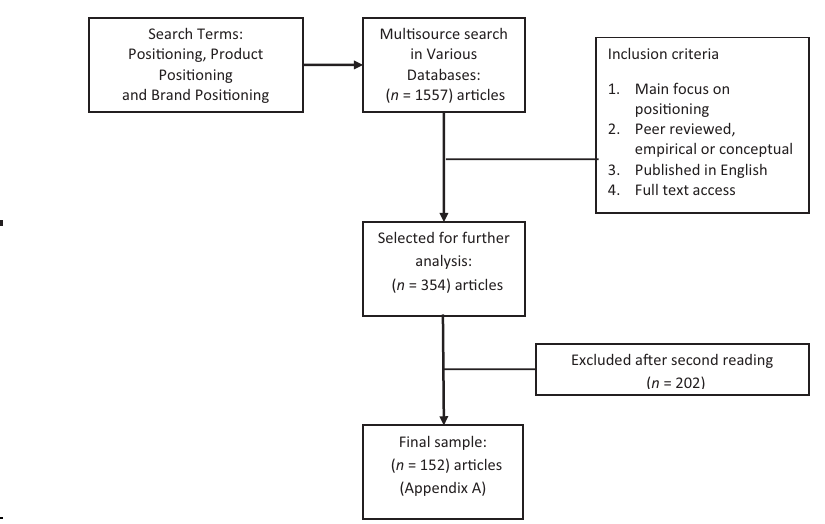
Figure 1. Flow diagram